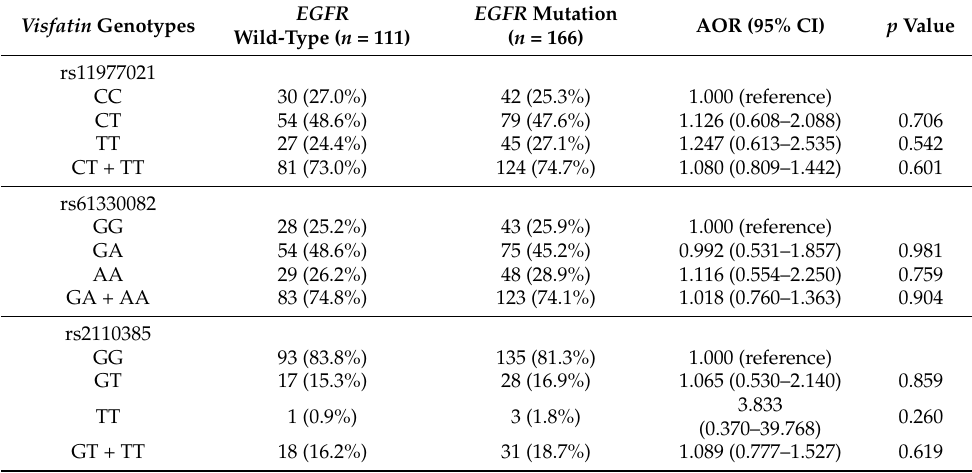
Table 3. Distribution frequency of visfatin genotypes and multiple logistic regression analysis of EGFR mutation status in lung adenocarcinoma